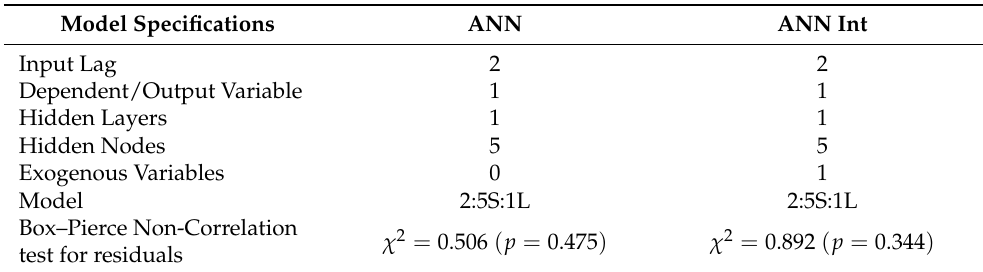
Table 4. Parameter specifications of the ANN and ANN intervention models.